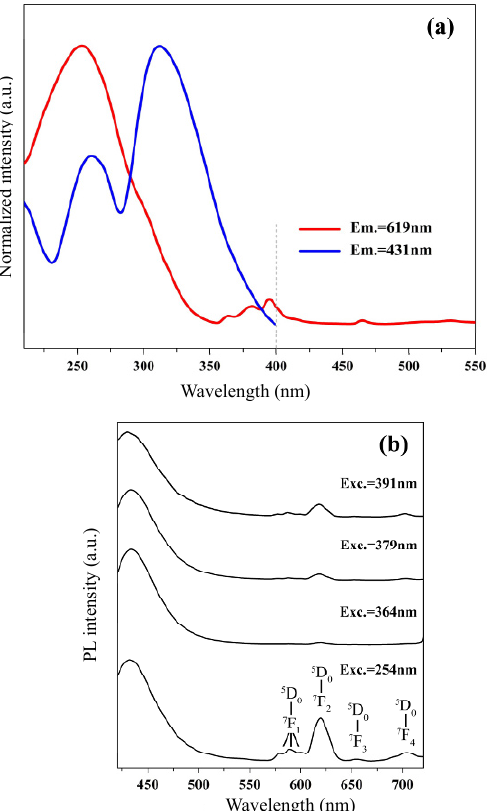
Fig. 3 (a) PLE spectra of Eu 3+ (619 nm) and Eu 2+ (431 nm) emissions of Ba 0.79 Al 10.9 O 17.14 :0.04Eu and (b) PL spectra with different excitation